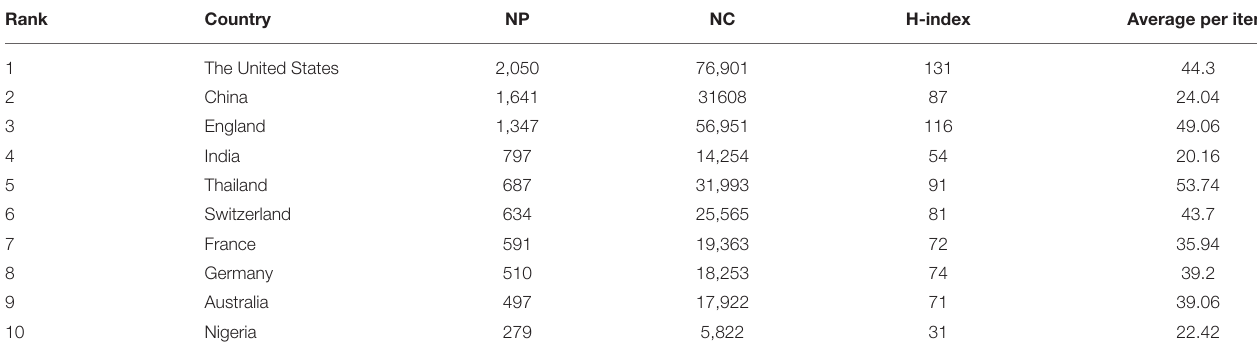
TABLE 1 | Publications in the top 10 productive countries/regions.